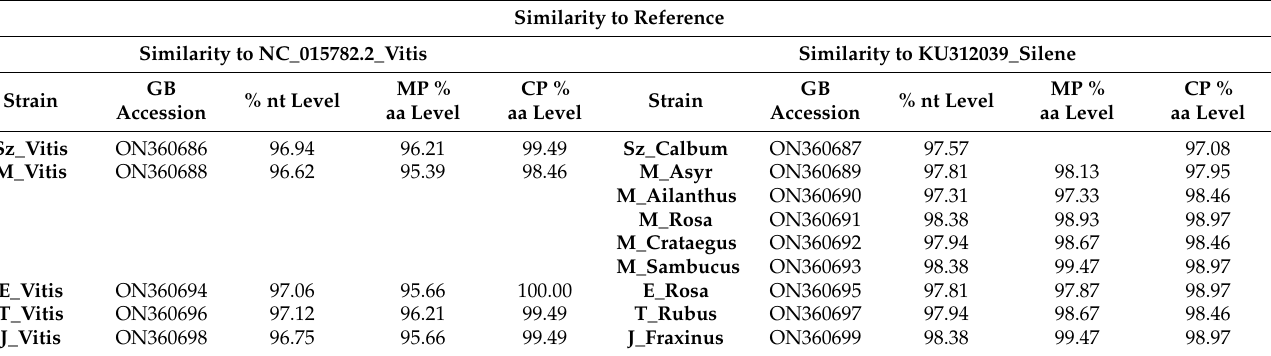
Table 3. Similarity of sequenced MP/CP coding part of GPGV strains to reference genome. Sequences from grapevine were compared to grapevine-originated reference, while sequences from weeds were compared to full GPGV genome originated from